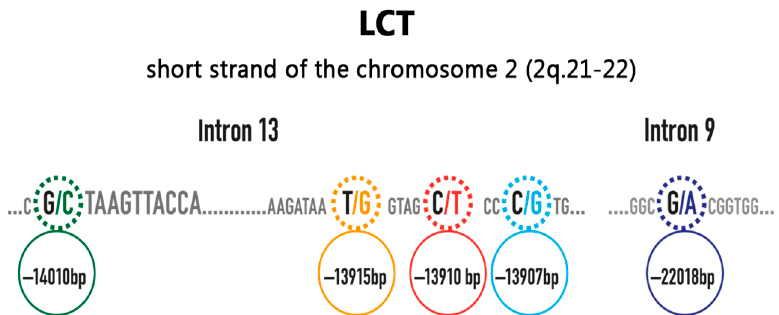
Figure 2. Some of the most important single nucleotide polymorphisms in the lactase gene (modified from [13]).